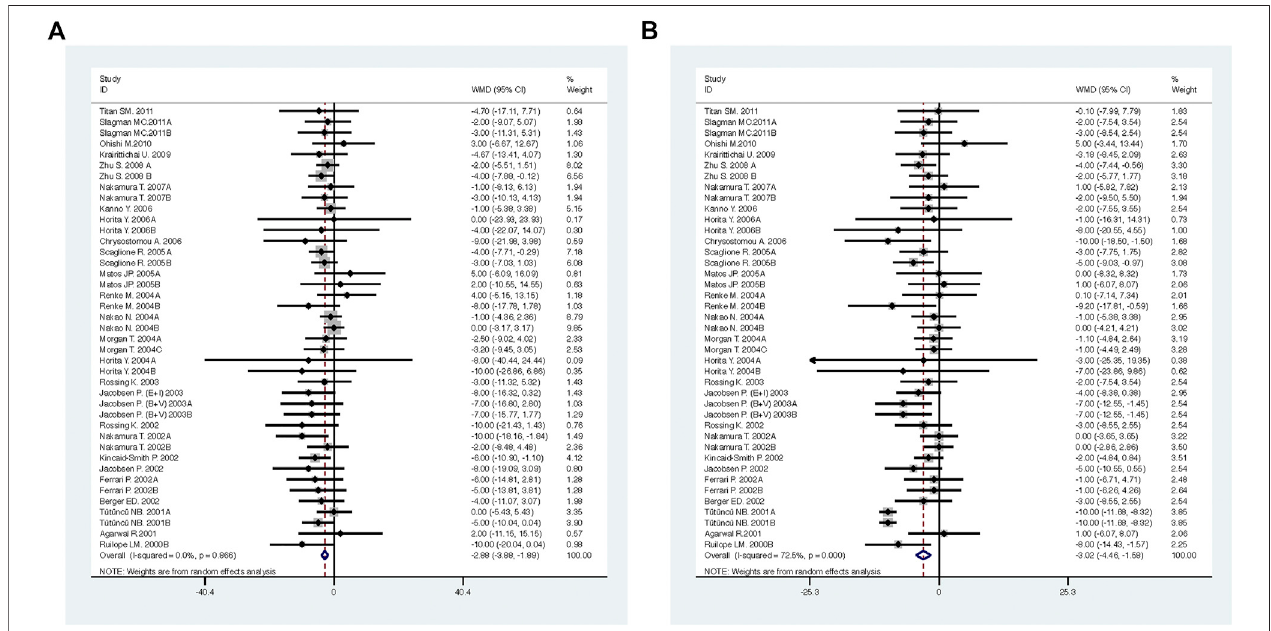
FIGURE 4 | Comparison of ACEI in combination with ARB vs. low-dose ACEI or ARB for blood pressure. (A) systolic blood pressure (mmHg), (B) diastolic blood pressure (mmHg).